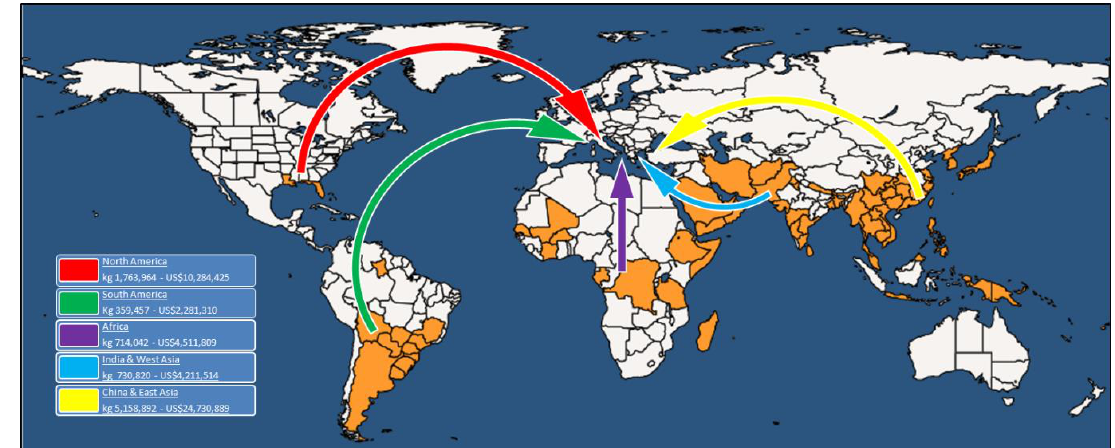
Figure 3. Areas from which X. citri may have originated in the Mediterranean Basin through imports